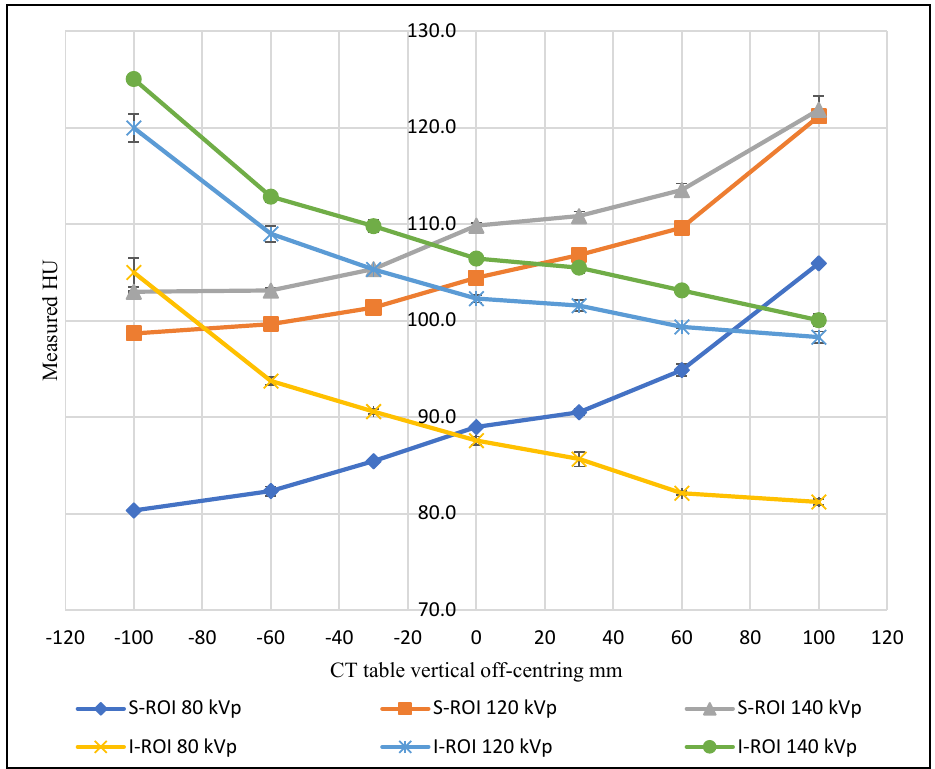
Figure 5. The CT number change of superior and inferior ROIs in the abdominal scans as a function of phantom vertical off-centring using different tube voltages.